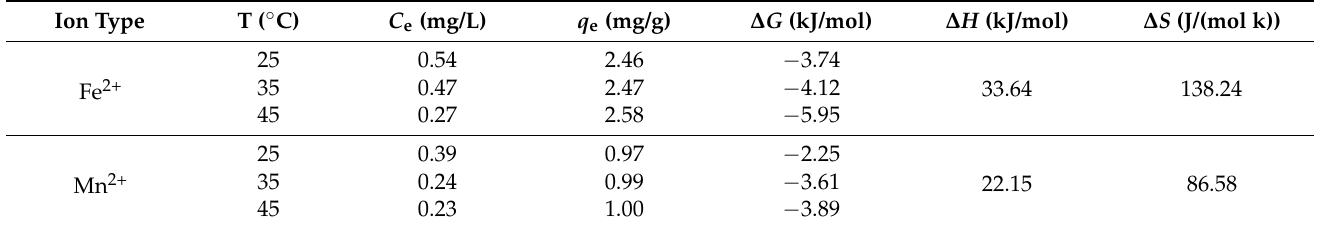
Table 2. Thermodynamic parameters of IHA/TM adsorption of Fe 2+ and Mn 2+ .